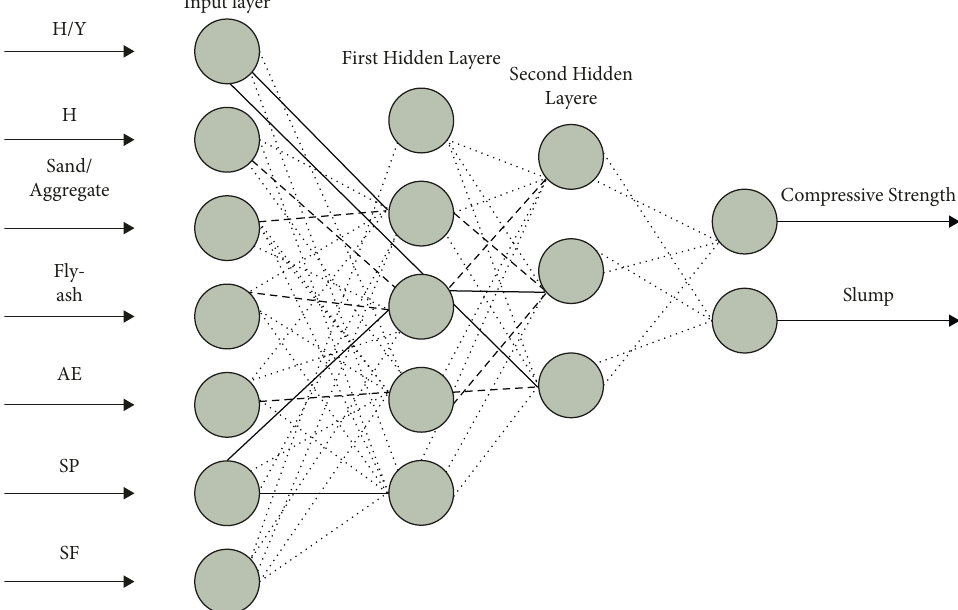
Figure 2: Neural network